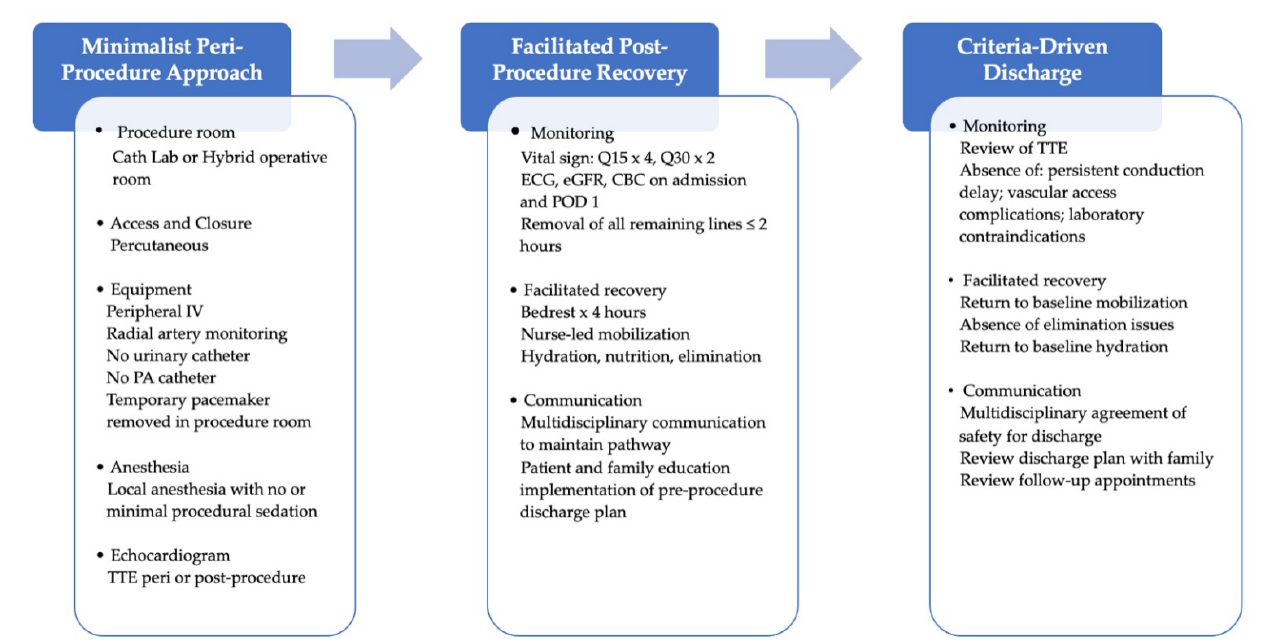
Figure 2. 3M TAVI clinical pathway adapted from Wood DA et al. [7]. CBC = complete blood count; ECG = electrocardiogram; eGFR = estimated glomerular filtration rate; IV = intravenous; PA = pulmonary artery; POD1 = post-operative day 1; Q15 = every 15 min; Q30 = every 30 min; TTE = transthoracic echocardiography.